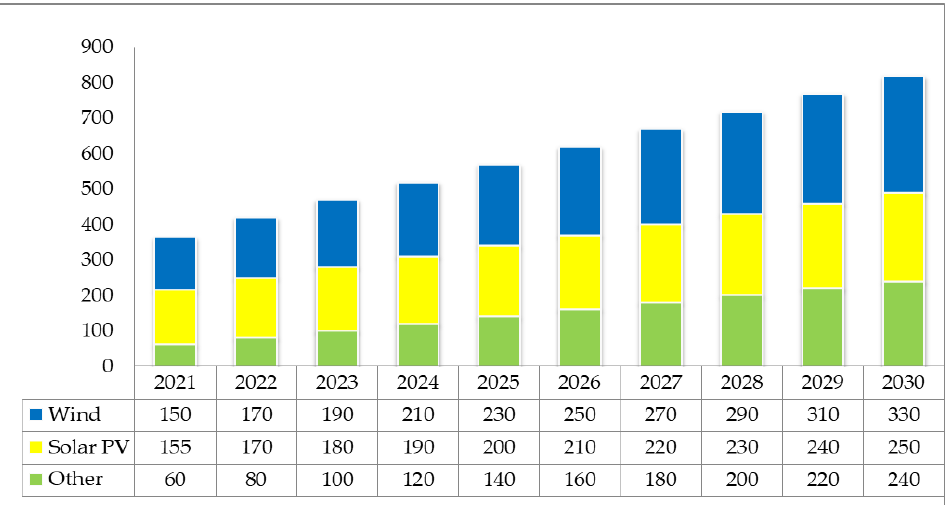
Figure 2. Projected capacity quotas (in MW) for renewable energy sources [30].